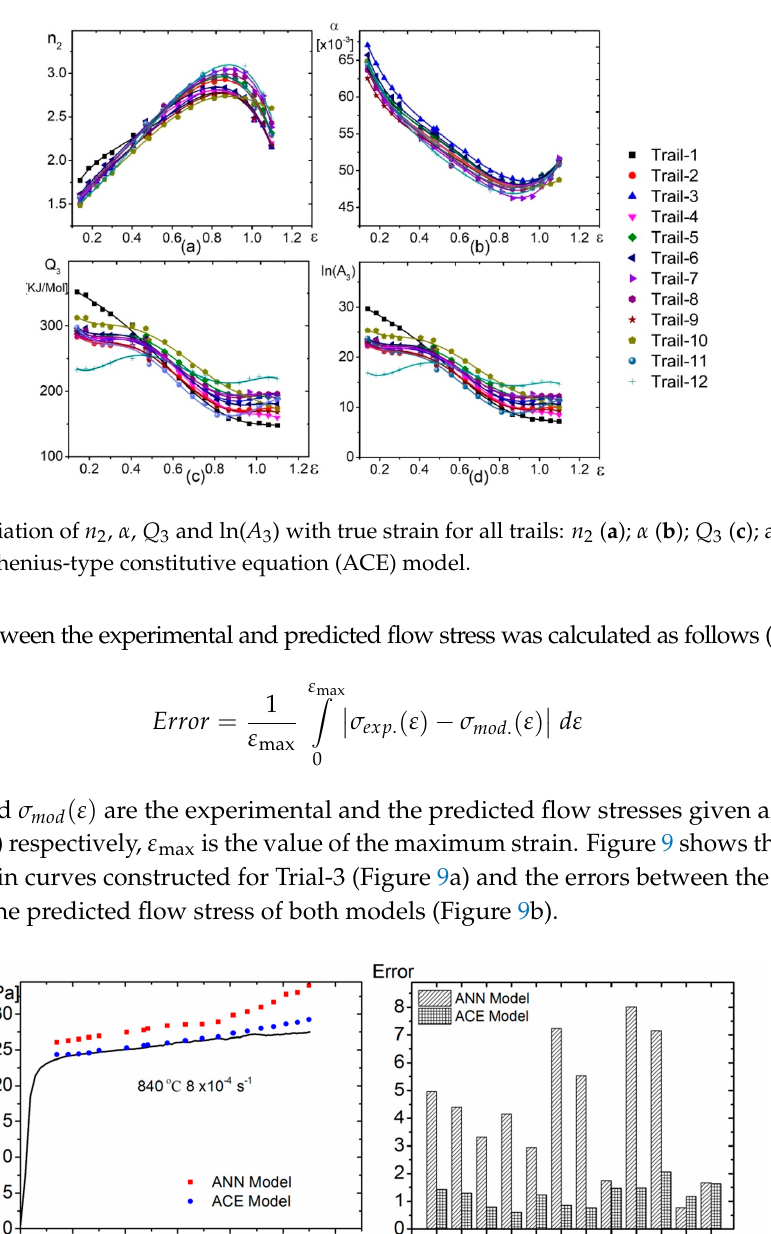
Figure 9. Comparison between the experimental flow stress and Predicted flow stress from both models ( a ) and the Error between experimental and tested flow stress ( b ).